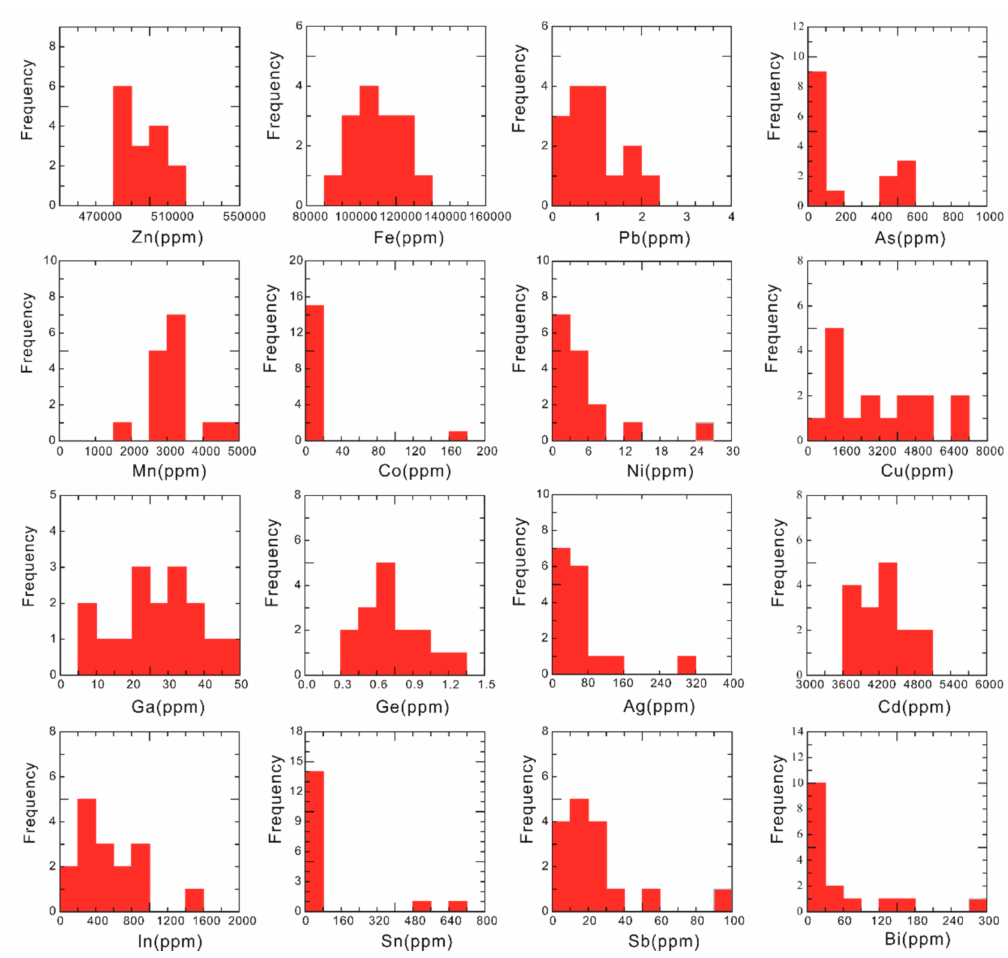
Figure 11. Histogram of trace elements for sphalerite of the stratabound Ag-Pb-Zn-Cu ores from the Laochang